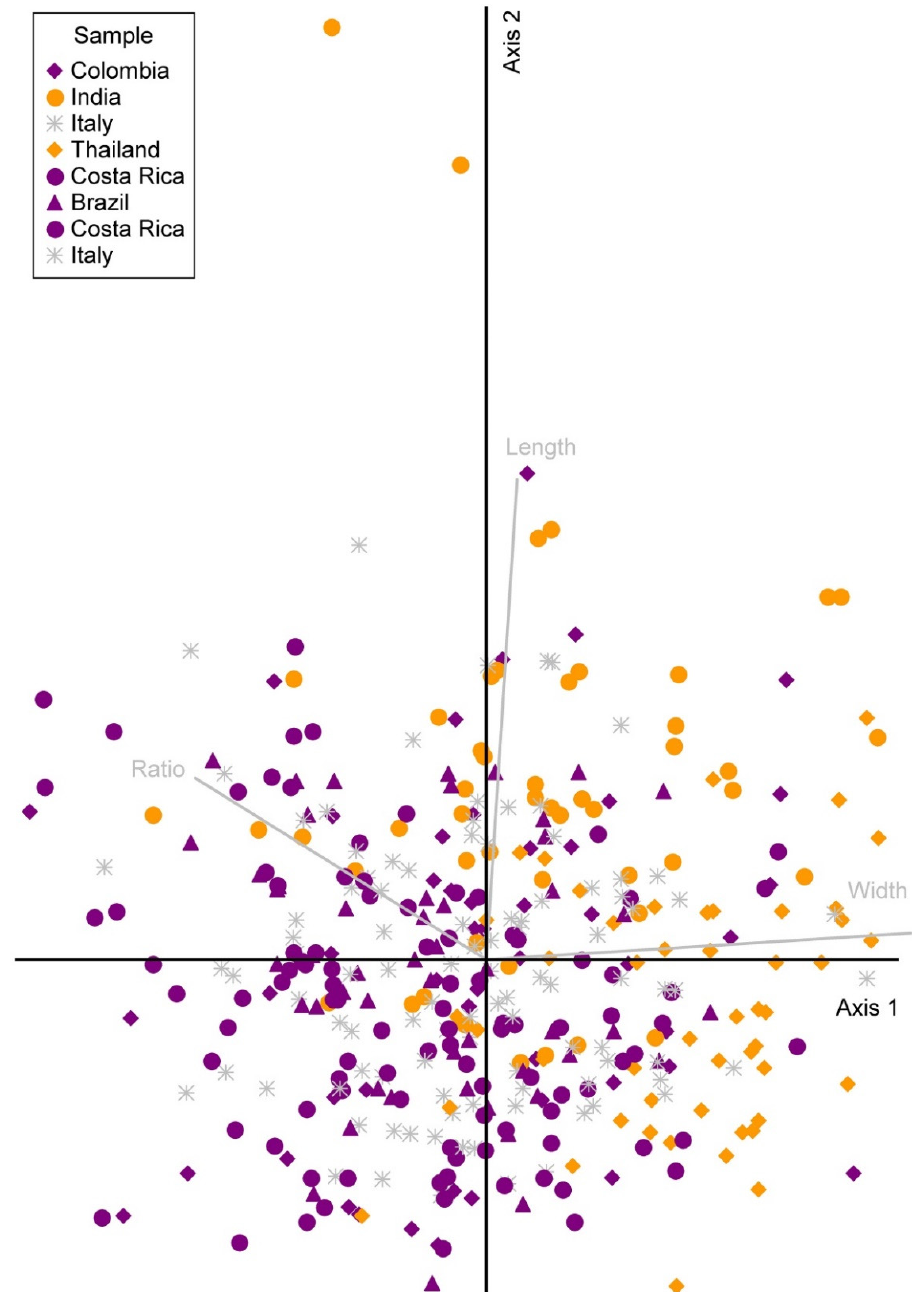
Figure 2. PCA plot of the ascospore length and width. Measurements were taken for eight specimens, which included fresh and herbarium specimens from 50 ascospores of each specimen. Brazil: C á ceres and Aptroot 11449; Colombia: Lindig 2865; Costa Rica: Tibell 8232, Tibell 8306; India: Kurz 1866; Italy: Beltramini s.n. (L-008798, L-996762); Thailand: MFLU